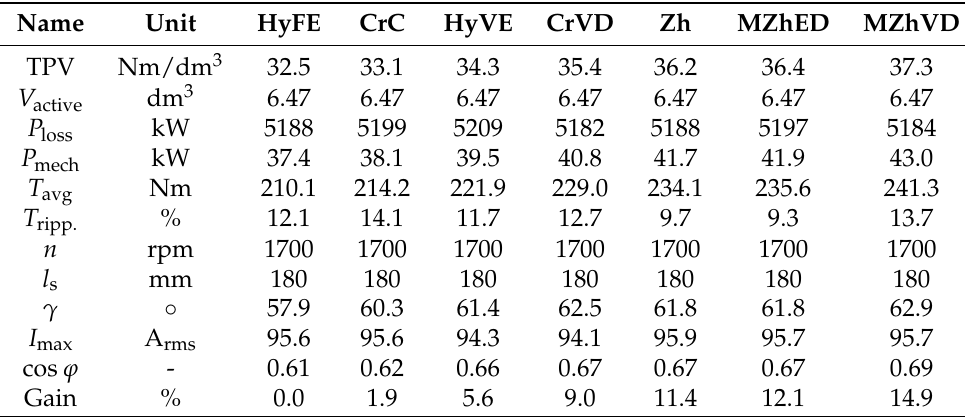
Table 5. Optimization result comparison table